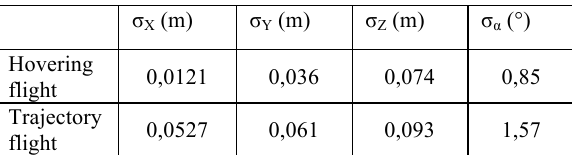
Figure 4. Assembled motion capture system, the test field and Parrot AR.Drone 2.0 UAV